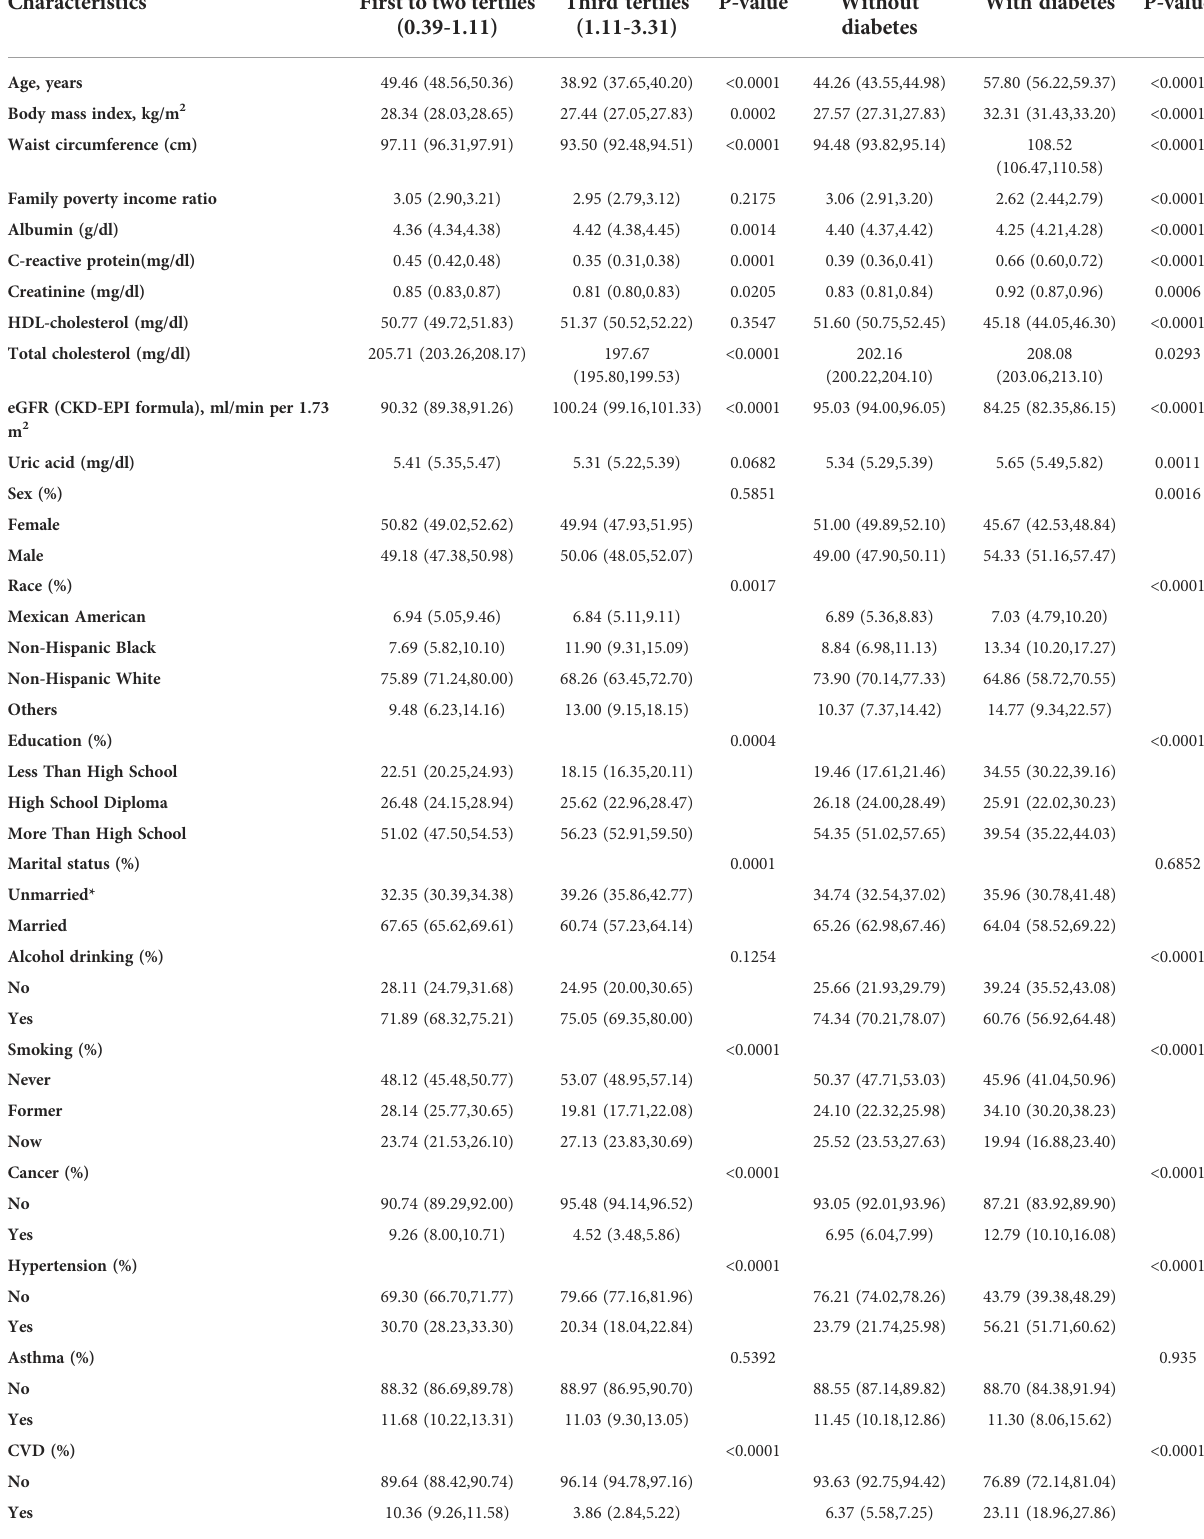
TABLE 1 Baseline characteristics of participants by telomere length tertiles and status of diabetes, weighted.